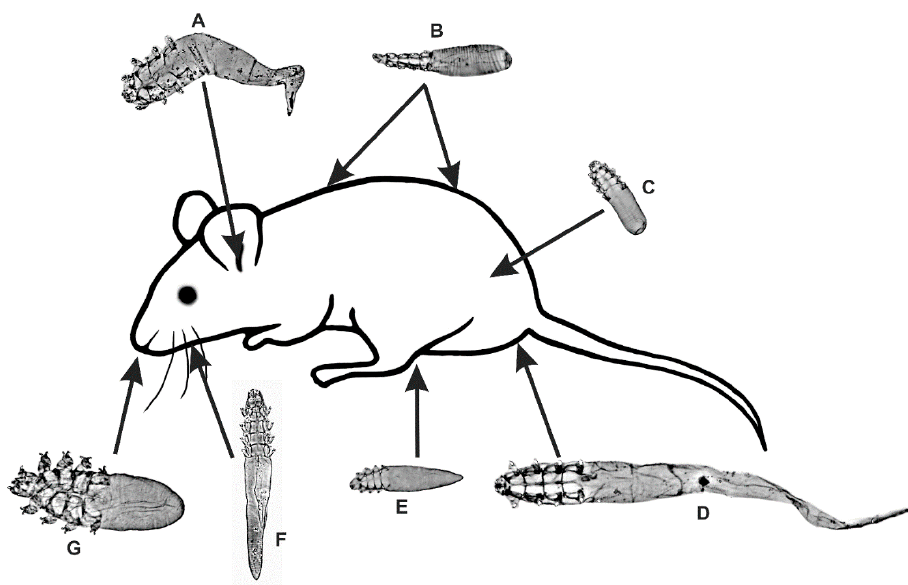
Figure 5. Topographic preferences of demodecid mites in house mouse: ( A ) Demodex conicus . ( B ) Demodex musculi . ( C ) Demodex marculus . ( D ). Demodex flagellurus . ( E ) Demodex fusiformis . ( F ) Demodex vibrissae . ( G ) Glossicodex musculi .